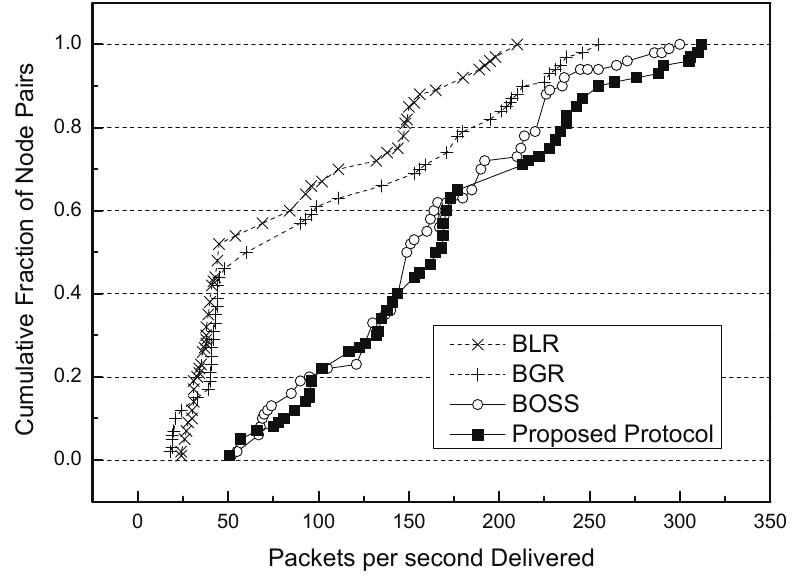
Figure 7. Data throughputs CDFs of 50 randomly-selected node